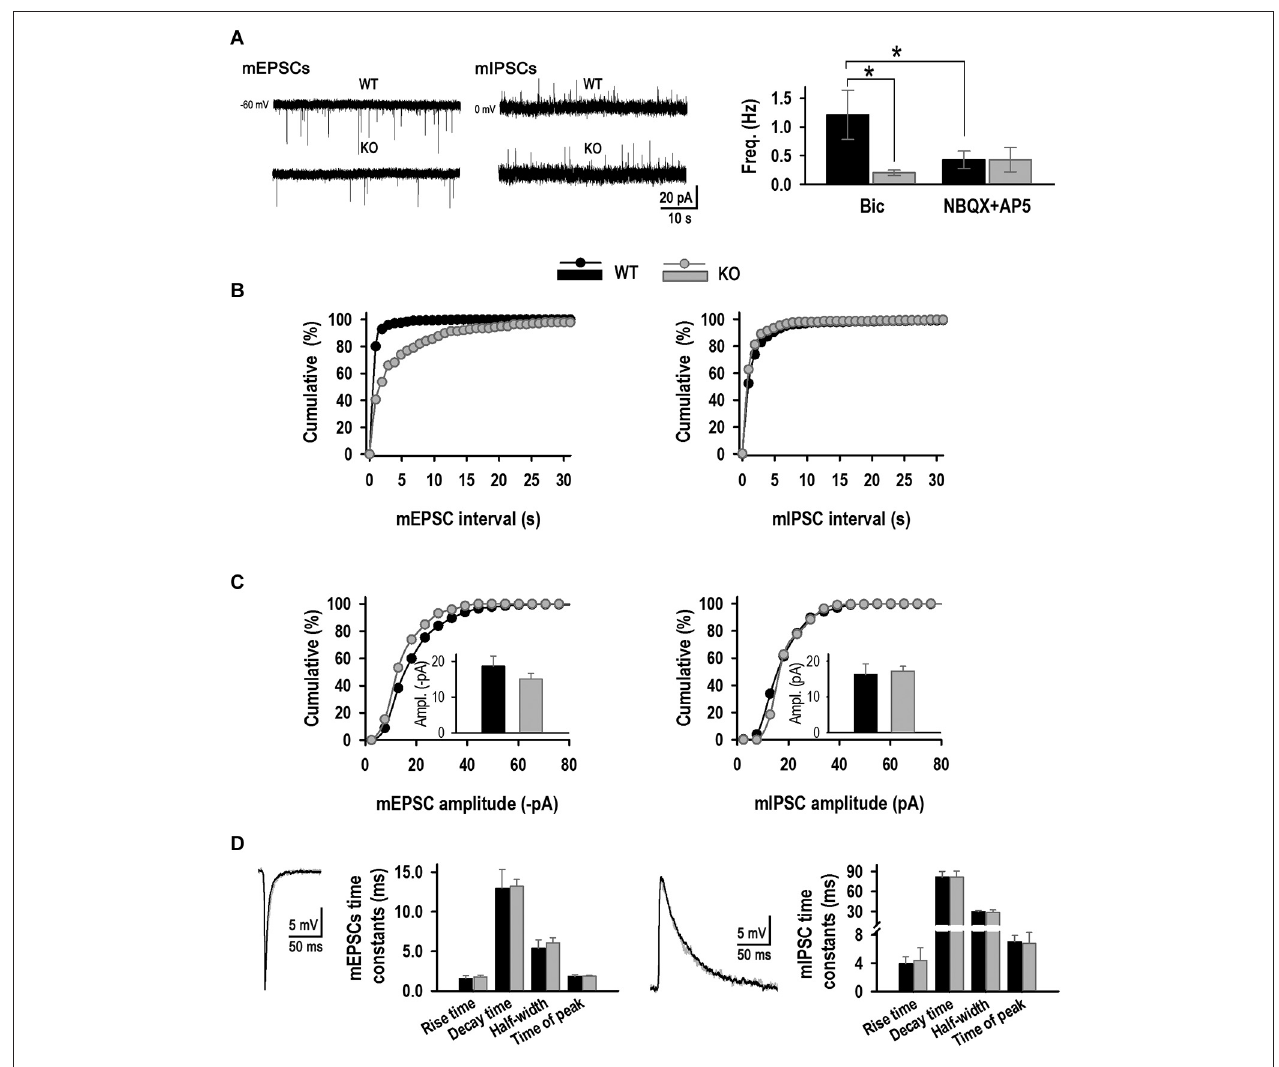
distribution for WT and KO neurons. Inset , mean amplitude value for each population (pA) ( n = 6, 7, 7, 7). (D) Kinetic analysis. Averaged mEPSC and mIPSC traces for WT and KO synapses. * p < 0.05,